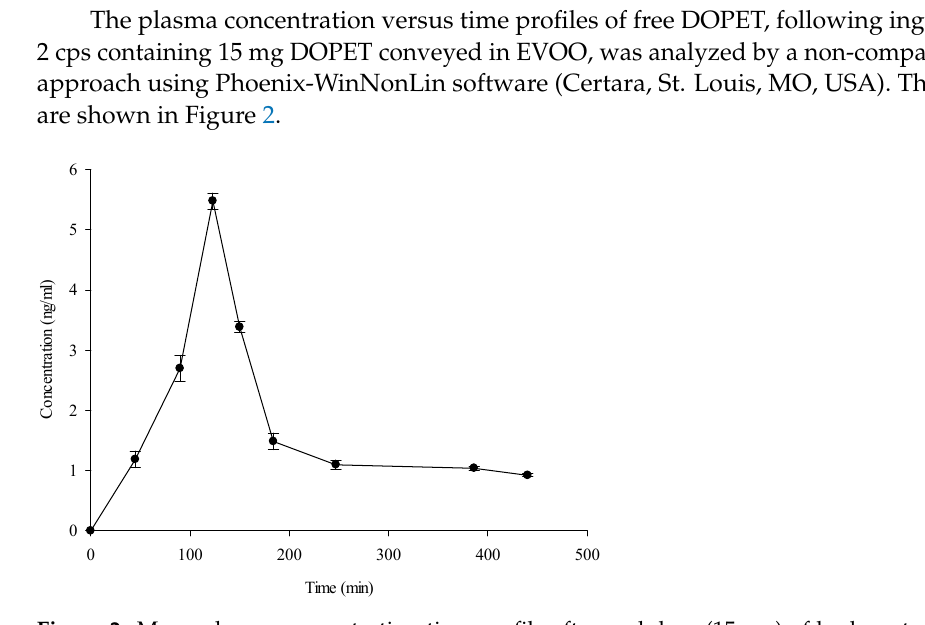
Figure 2. Mean plasma concentration ‐ time profile after oral dose (15 mg) of hydroxytyrosol (3,4 ‐ dihydroxy ‐ phenylethanol, DOPET). Results represent the concentration (ng/mL) expressed as mean ± standard deviation ( n = 20). The mean plasma concentration ‐ time profile shows C max and T max values of 5.48 ng/mL and 123 min, respectively. The T max value found is compatible with a gastro ‐ resistant formulation, considering that gastric emptying occurs in about two hours. Using the time ‐ course values, other pharmacokinetics parameters such as half ‐ life time (T 1/2 ), the area under the curve (AUC 0–440 min ), AUC from T 0 to T ∞ (AUC 0– ∞ ), AUC extrapolated_predicted (AUC extrap_pred ), the concentration at T last (440 min) (C last ), and first ‐ order rate constant associated with the terminal (log ‐ linear) portion of the curve (K el ) were calculated (Table 3). The AUC 0–440 min represents the time ‐ averaged concentration of free DOPET circulating in the plasma compartment in the time ‐ lapse, taking into account for pharmacokinetic study. On the contrary, AUC 0– ∞ is the AUC from time 0 extrapolated to infinite time. This parameter is calculated using the following equation: AUC (cid:2868) – (cid:2998) (cid:3404) AUC (cid:2868) – (cid:2872)(cid:2872)(cid:2868) (cid:3397) AUC (cid:2872)(cid:2872)(cid:2868) – (cid:2998) Assuming that DOPET is eliminated mono ‐ exponentially after the last measurable concentration, and that no other process than elimination is involved, the terminal elimination rate of DOPET can be accurately estimated from the elimination constant calculated with the experimental data. This elimination rate is not affected by time or plasma concentrations of DOPET. Furthermore, assuming that other processes such as absorption and distribution in the terminal phase of the pharmacokinetic process are not involved, we can treat the extrapolated portion of the AUC like an IV bolus dose. Considering this, the AUC 0–440 min can be calculated as the following: AUC (cid:2872)(cid:2872)(cid:2868) – (cid:2998) (cid:3404) C (cid:2922)(cid:2911)(cid:2929)(cid:2930) K (cid:2915)(cid:2922) This extrapolated AUC is then added to the observed AUC to give the total AUC value.